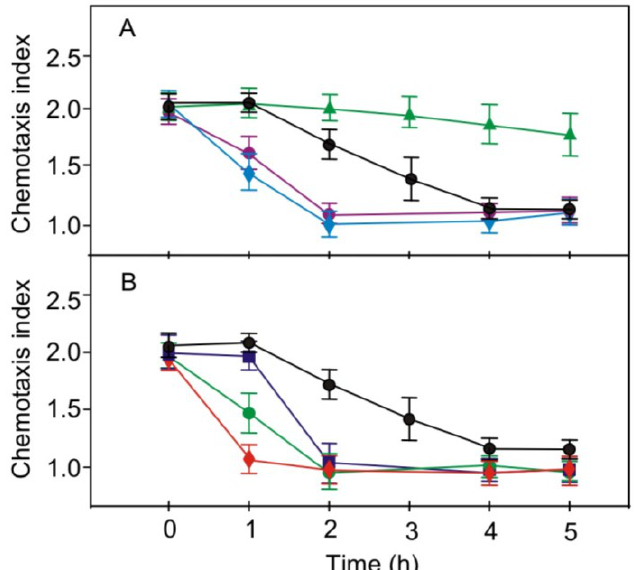
Figure 5. Effects of various pharmacological compounds on the light-induced loss of chemotaxis towards nitrite in pregametes of phototropin-reduced strain RNAi20. ( A )